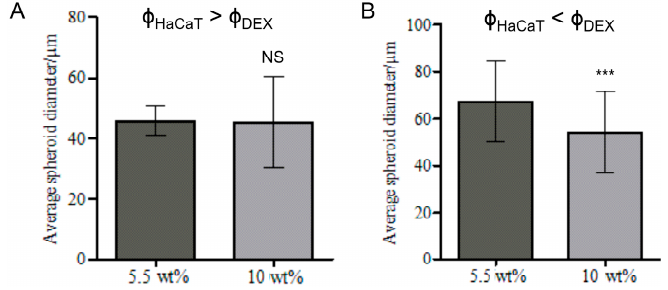
Figure 6. Average HaCaT spheroid diameter for emulsions 5.5 wt% PEO/5.5 wt% DEX or 10 wt% PEO/5.5 wt% DEX ( A ) ф HaCaT = 0.25, ф DEX = 0.2 and( B ) ф HaCaT = 0.15, ф DEX = 0.25. The data were obtained by optical microscopy measurements of clusteroids for each micrograph with ImageJ Software (Student’s t -Test, NS: Non-significant, *** p < 0.001).